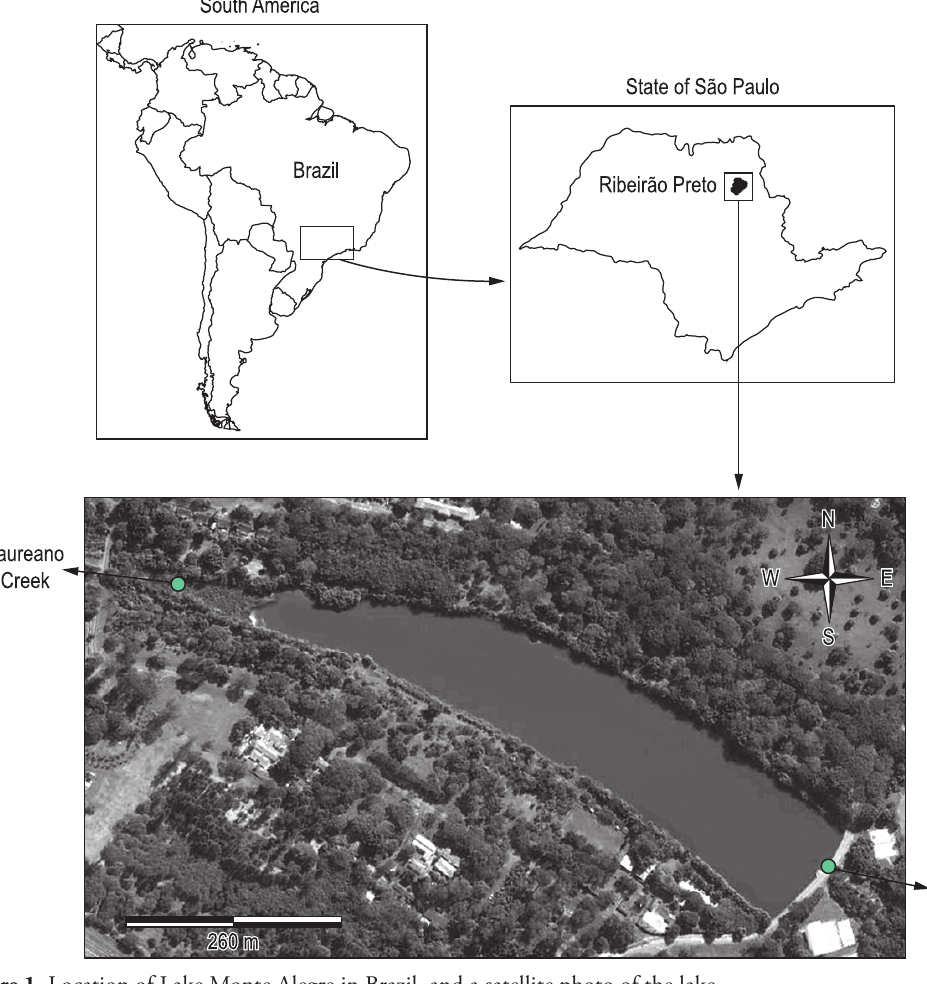
Figure 1. Location of Lake Monte Alegre in Brazil, and a satellite photo of the